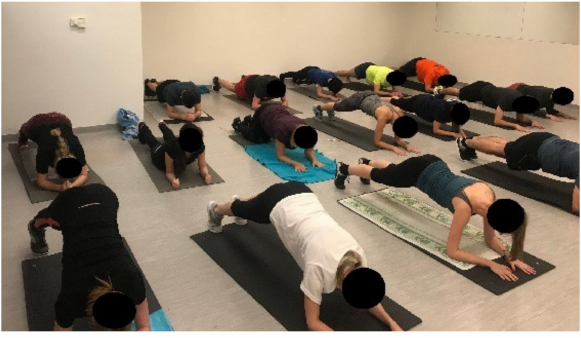
Figure 5. Prone bridging (plank).